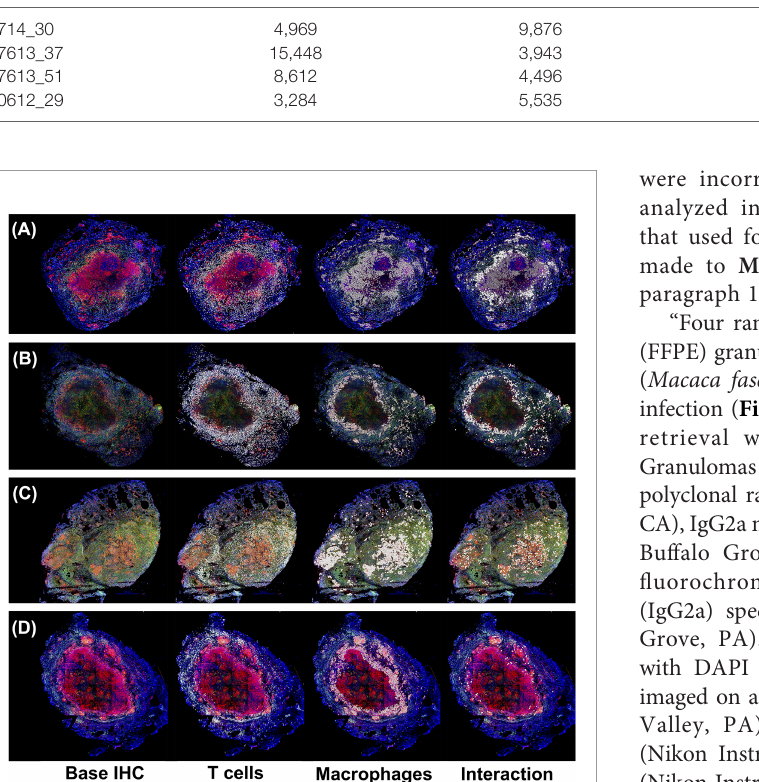
FIGURE 1 | Immunohistochemistry analysis of four non-human primates (NHP) granulomas [shown in Panels (A – D) ] examining spatial distributions of both T cells and macrophages, and also where they intersect. Four distinct, randomly chosen granuloma images with extracted cell distributions. Column 1 shows the immunohistochemically stained preparation for CD3 (green), CD11c+ macrophages (red), and nuclei (dark blue). White points represent Geographical Information Systems Technology (GIS) analyses of these images revealing cell locations for T cells (Column 2), macrophages (Column 3), and their intersections (Column 4), as follows. Rows represent four distinct granulomas. The data for the cell numbers in these granulomas are given in Table 2. On average, about 9.75% (median 8.6%, StDev is 4.5%) of T cells interacted with